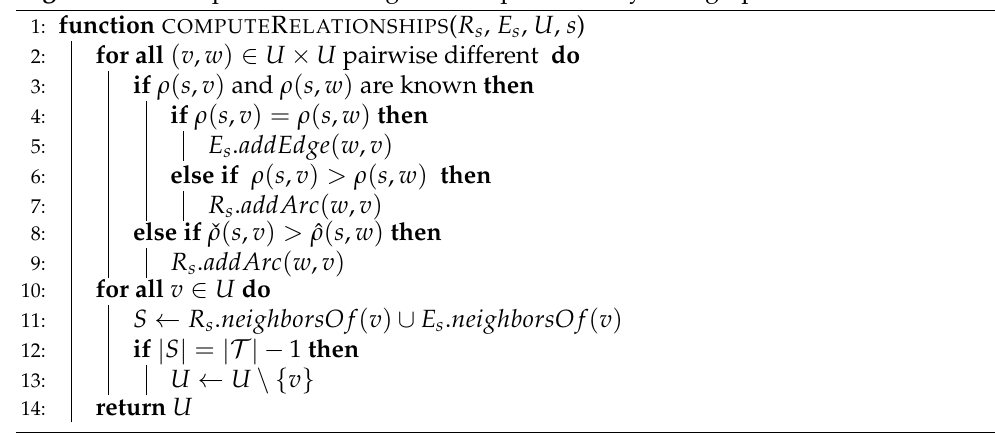
Algorithm 2 Complete the ranking that is represented by both